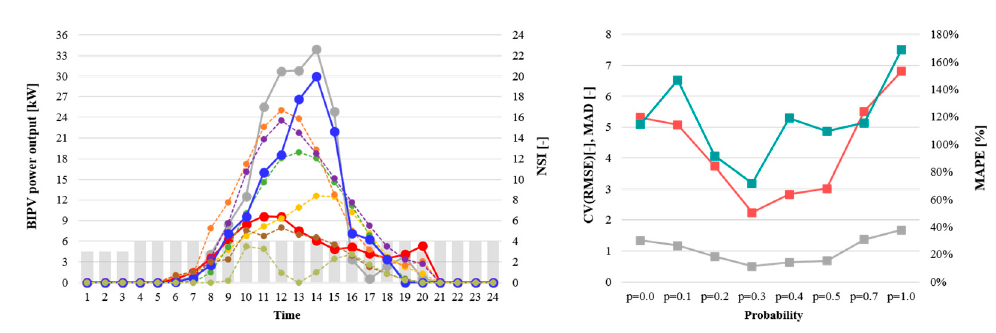
Figure 8. A comparison of the prediction results of the BIPV power output for specific days using the observation dropout technique. Energies 2019 , 12 , x FOR PEER REVIEW